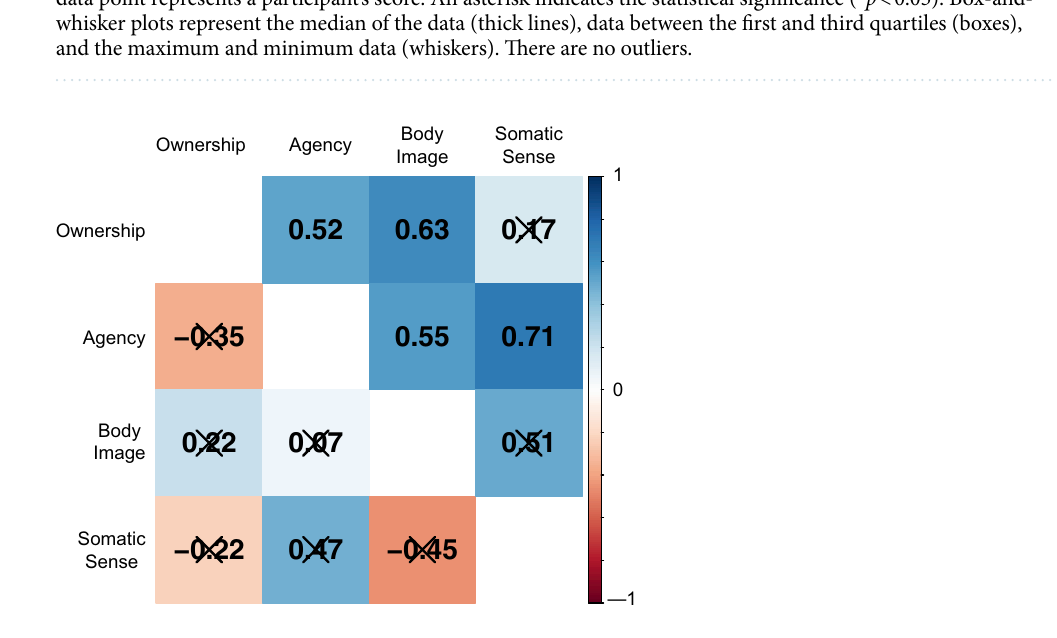
Figure 4. Correlation matrix between subjective ratings for disruption of body-related awareness. Upper triangle represents correlation coefficients in the Display condition and the lower part represents the Hide condition. X-marks on values indicate statistically non-significant correlations ( p >